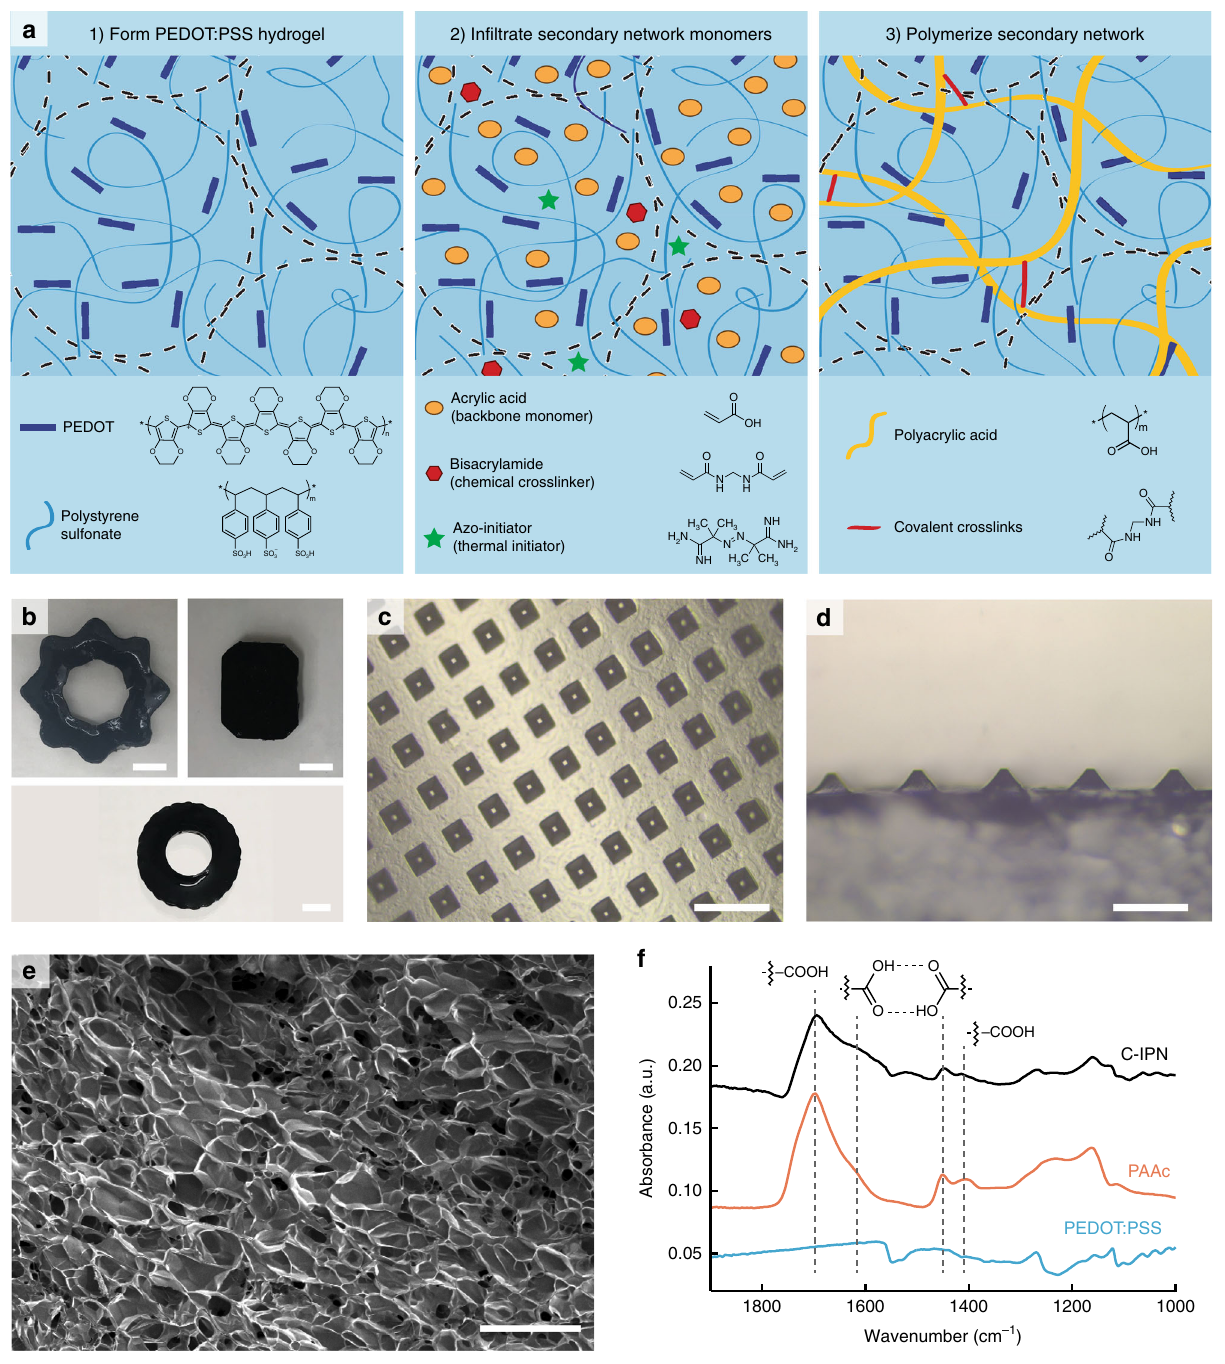
Fig. 1 Fabrication and structure of C-IPN hydrogels. a Process for fabricating C-IPN hydrogels. First, PEDOT:PSS hydrogels are formed from aqueous solutions of PEDOT:PSS by using ionic liquid to screen the electrostatic repulsions between PEDOT:PSS microgels, enabling them to aggregate into a macroscopically connected network. Second, the PEDOT:PSS hydrogel is in fi ltrated with acrylic acid, bisacrylamide, and an azo-initiator. Finally, the polyacrylic acid network is formed by polymerizing the monomers in water at 70 °C. b Various large shapes made by casting the PEDOT:PSS/acrylic acid mixture into different silicone soap molds. Scale bars are 1 cm. c , d C-IPN can be micropatterned into pyramidal structures with features as small as 10 μ m by casting into silicon molds. Scale bar is 200 μ m c and 100 μ m d . e Cross-sectional SEM image of freeze-dried C-IPN showing that the fi nal gel is homogeneous and porous. Scale bar is 100 μ m. f FTIR spectra of PEDOT:PSS, PAAc, and C-IPN, showing a clear presence of PAAc within the C-IPN (CuCl 2 ) at the same overall ionic strength, and loaded the mixture which the mixture can fl ow readily. By comparison, mixing onto a parallel plate rheometer oscillating at a constant strain rate PEDOT:PSS with CuCl 2 at an equivalent ionic strength resulted in nearly immediate gelation: by the time the solution was loaded of 1% and a frequency of 1 Hz. With the ionic liquid mixture, the onto the rheometer, G ’ already exceeded G ” (Fig. 2c). The crossover point at which G ’ > G ” occurs after 15 min, before